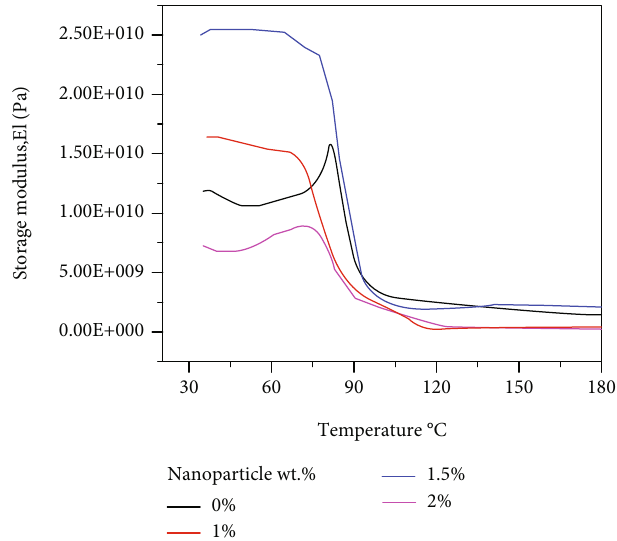
Figure 8: Storage modulus vs. temperature plot for the epoxy nanocomposites.